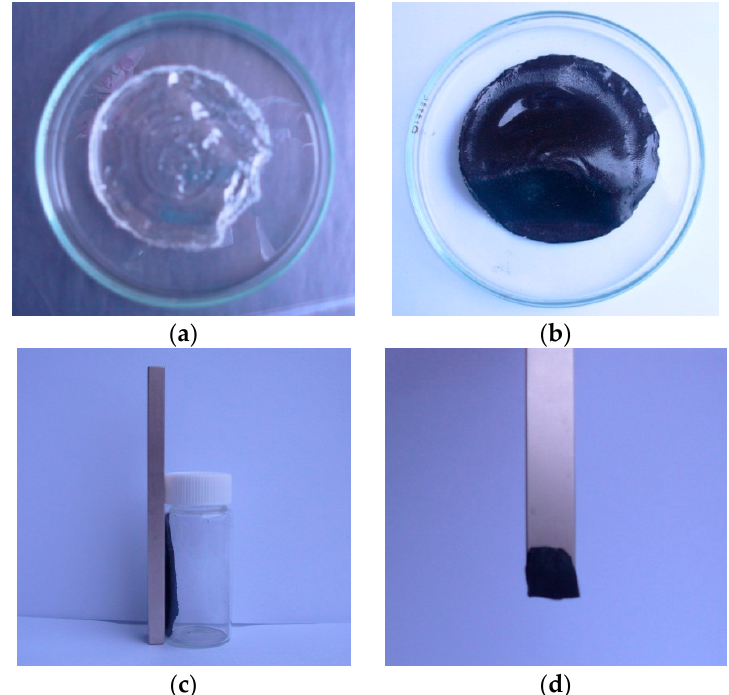
Figure 1. Photographs of ( a ) PVA gel; ( b ) PVA/Ni magnetic gel; ( c ) Ni-nanoparticle (NPs) in the magnet field; ( d ) PVA/Ni magnetic gel in the magnet field.